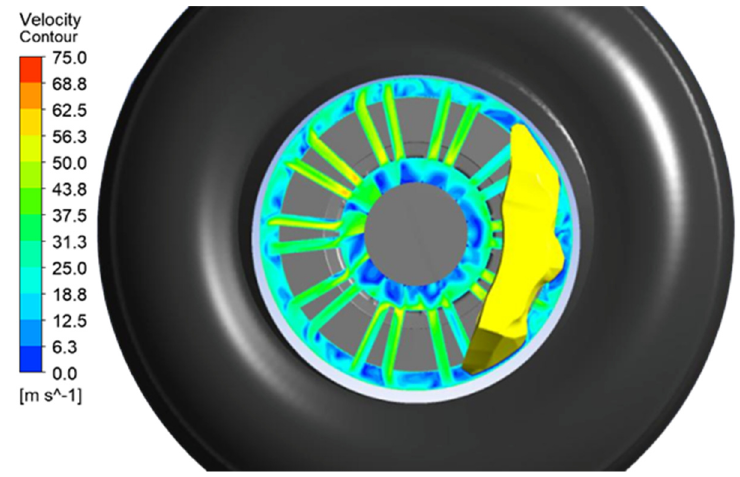
Figure 11. Velocity contours on the middle plane of the disk.